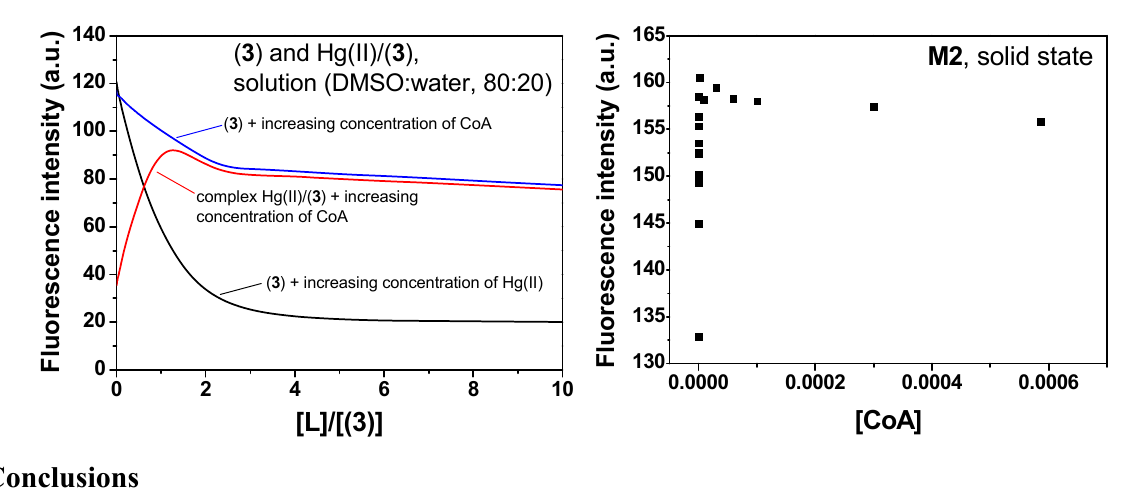
O (80:20) solution (left), and 2